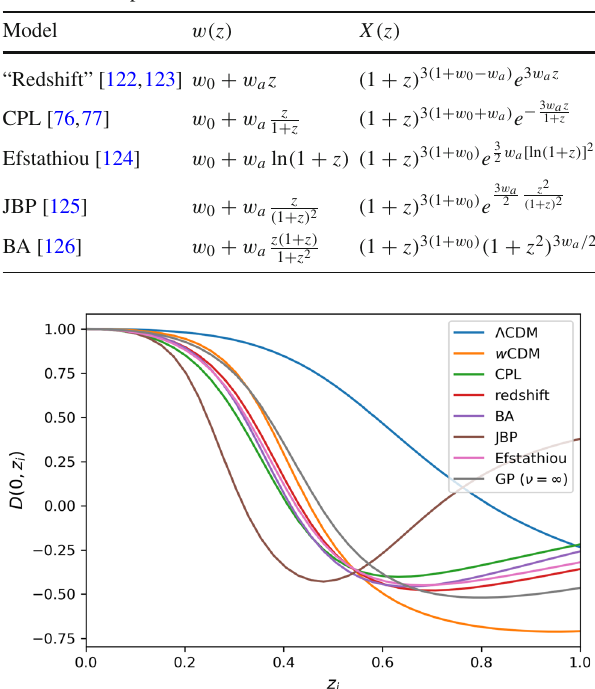
Fig. 3 Correlationsbetween H ( z = 0 ) and H ( z i ) acrossahostofDDE models. As expected, a model induces certain correlations between val- ues of observables at different redshifts and as depicted in FIG. 2, so